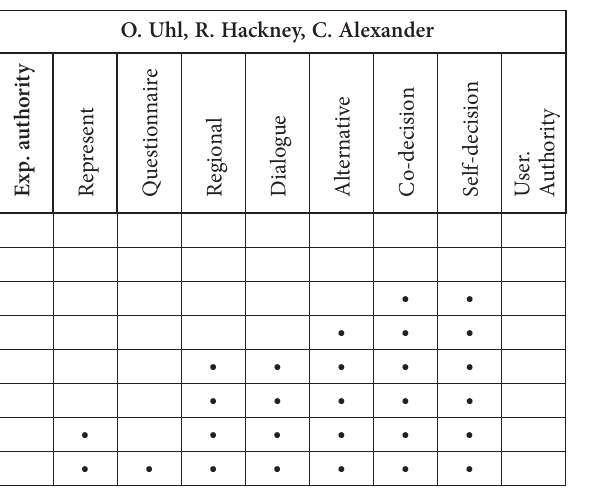
Table 4. Levels of design participation – works of Foster, BIG & SANNA (source: